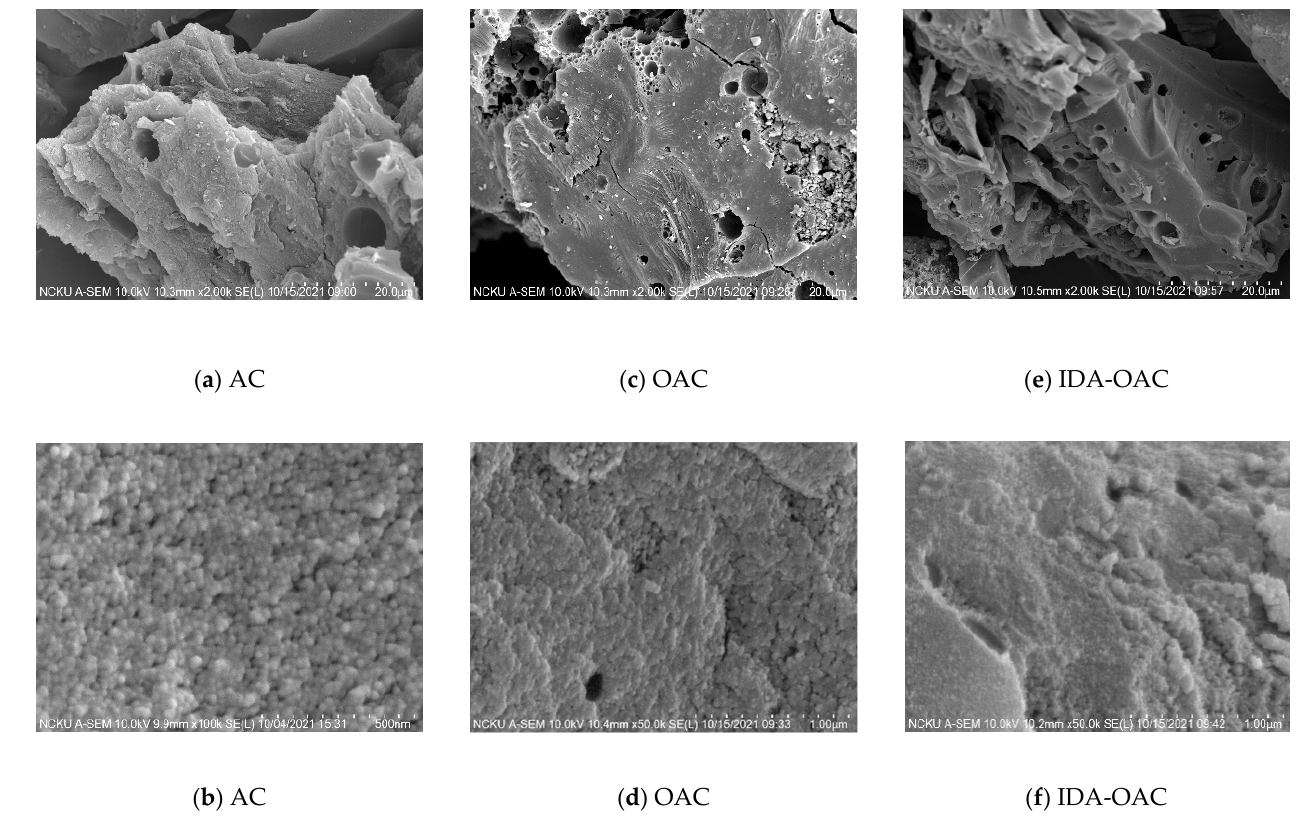
Figure 2. SEM images of ( a , b ) AC, ( c , d ) OAC, ( e , f ) IDA-OAC.